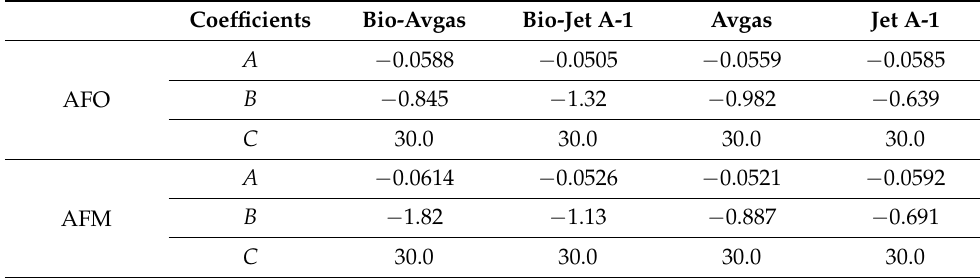
The coefficients { A , B , C } fitted to the experimental data using the least square approximation